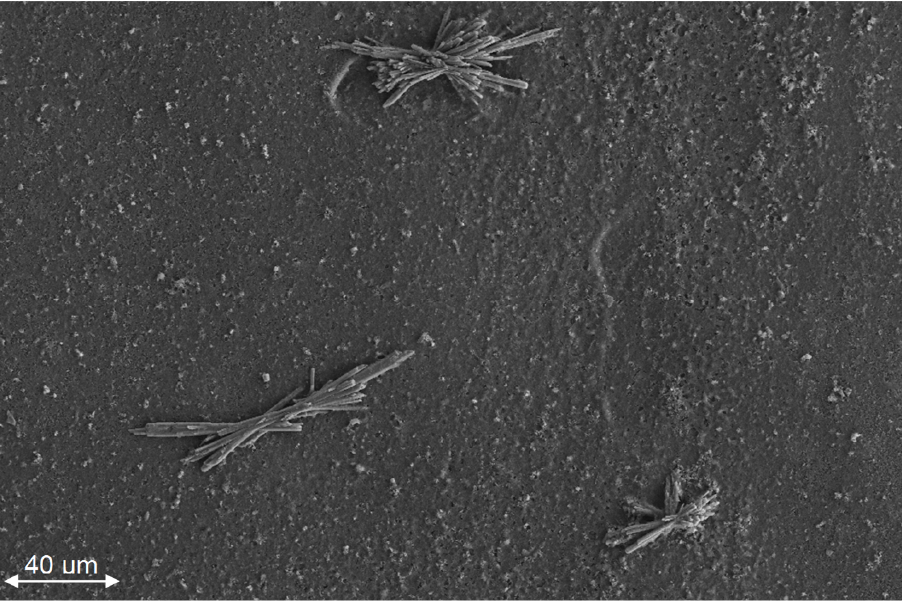
Figure A1. SEM surface image of the gypsum-scaled SNS-PAA-PA membrane. (Scaling test condi- tions: 24 h filtration with gypsum feed solution pH of 5.7, membrane surface saturation index of gypsum SI g,m = 1.3).